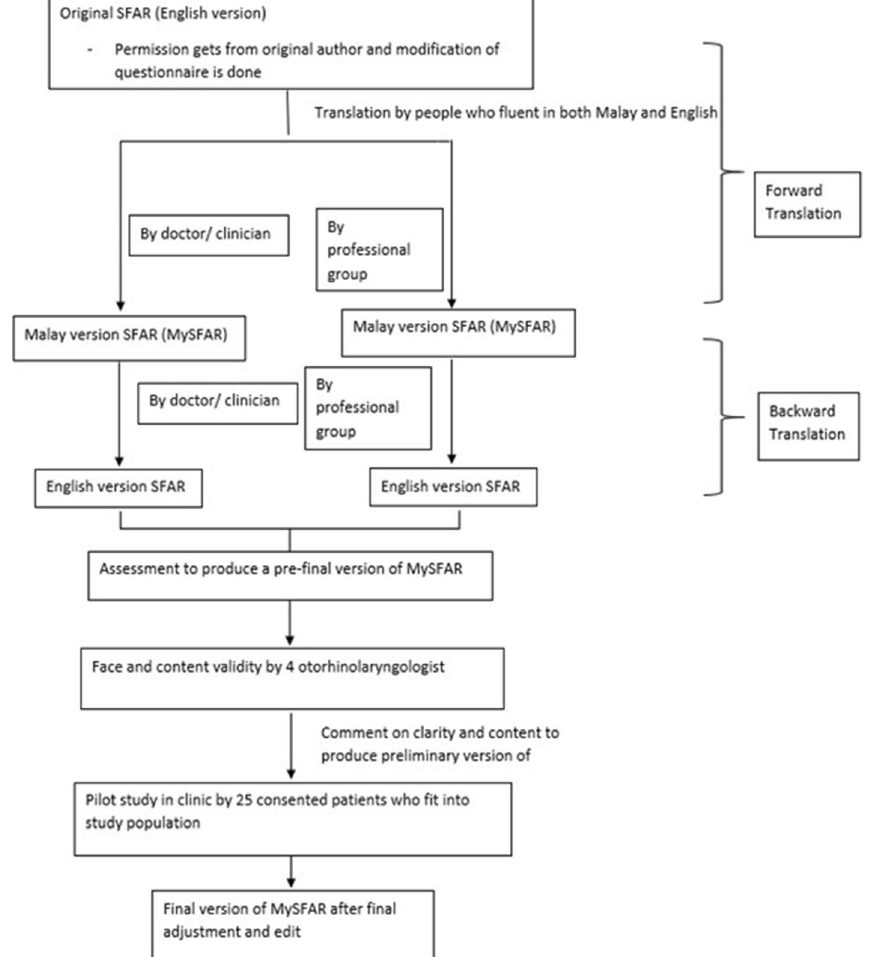
Fig. 1 Flow of study beginning from the translation procedure, content validation, and face validation to produce the Malaysian version score for allergic rhinitis (MySFAR)